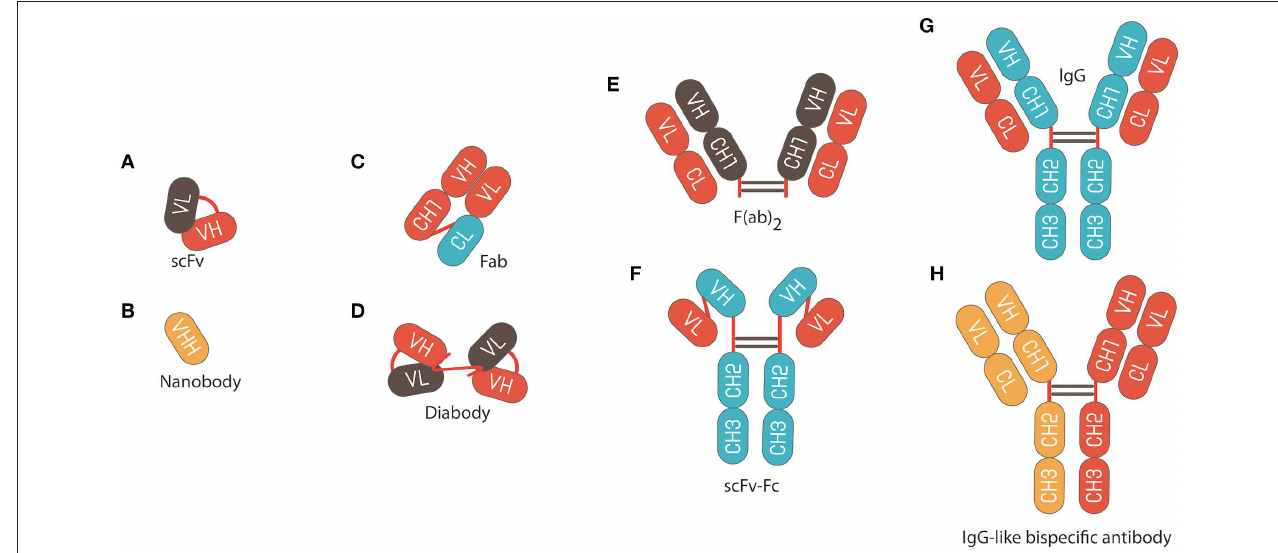
FIGURE 1 | Schematic representation of different antibody formats. (A) Single chain fragment variable (scFv) composed of variable regions of the light chain (V L ) linked to variable regions of the heavy chain (V H ) by a flexible glycine-serine linker (Gly 4 Ser) 3 . (B) Nanobody fragments. (C) Fragment of antigen binding (Fab) composed of V L and a constant domain of the light chain (CL) linked to V H and constant domain 1 of the heavy chain (CH1) by a disulphide bond between the CL and CH1 domains. (D) Diabody composed of V L linked to variable heavy V H by a pentameric (Gly 4 Ser). (E) F(ab)2 fragment composed of 2 × Fab fragments joined by an Immunoglobulin G (IgG) hinge region. (F) scFv fusion with an Fc IgG. (G) IgG composed of constant fragment (Fc), which is able to bind and stimulate immune effector cells, and Fab, which comprises the variable domains that contain the antigen binding regions. (H) Bispecific IgG